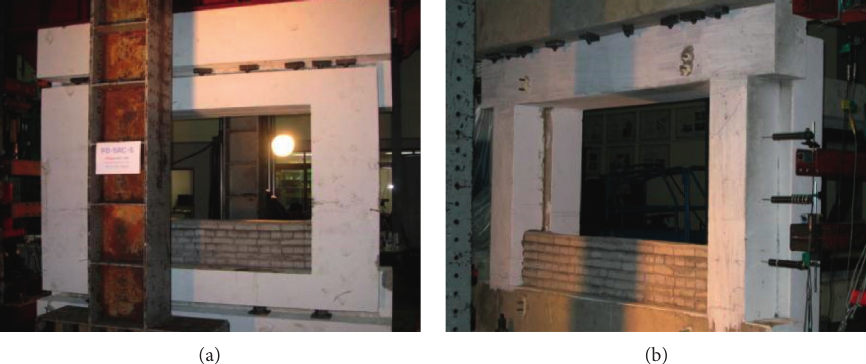
Figure 25: Cracks appeared in the PD-BESRCF specimen during pseudodynamic testing at 300 gal after (a) 2.55s with lateral displacement of 8.9mm and force of 381kN, and (b) during the final stage (7s).